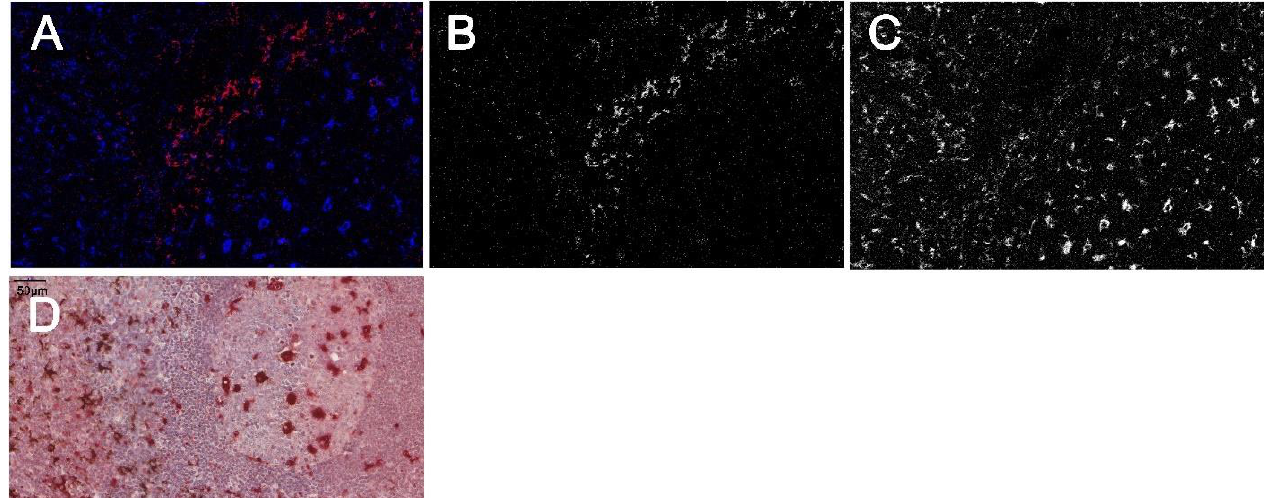
Figure 5. CyTOF based double staining with the modified FOLGAS protocol. ( A – C ) CyTOF ablation image: ( A ) merged image with CD163 in red (corresponding gray scale image in ( B )) and CD68 in blue (corresponding gray scale image in ( C )). ( D ) Double staining of the same slide prior to ablation. CD163 was stained first and developed/coated with a secondary antibody and DAB based brown color to shield the metal-labeled primary antibody. CD68 was stained second and labeled in red for better recognition. Magnification indicated by bar.